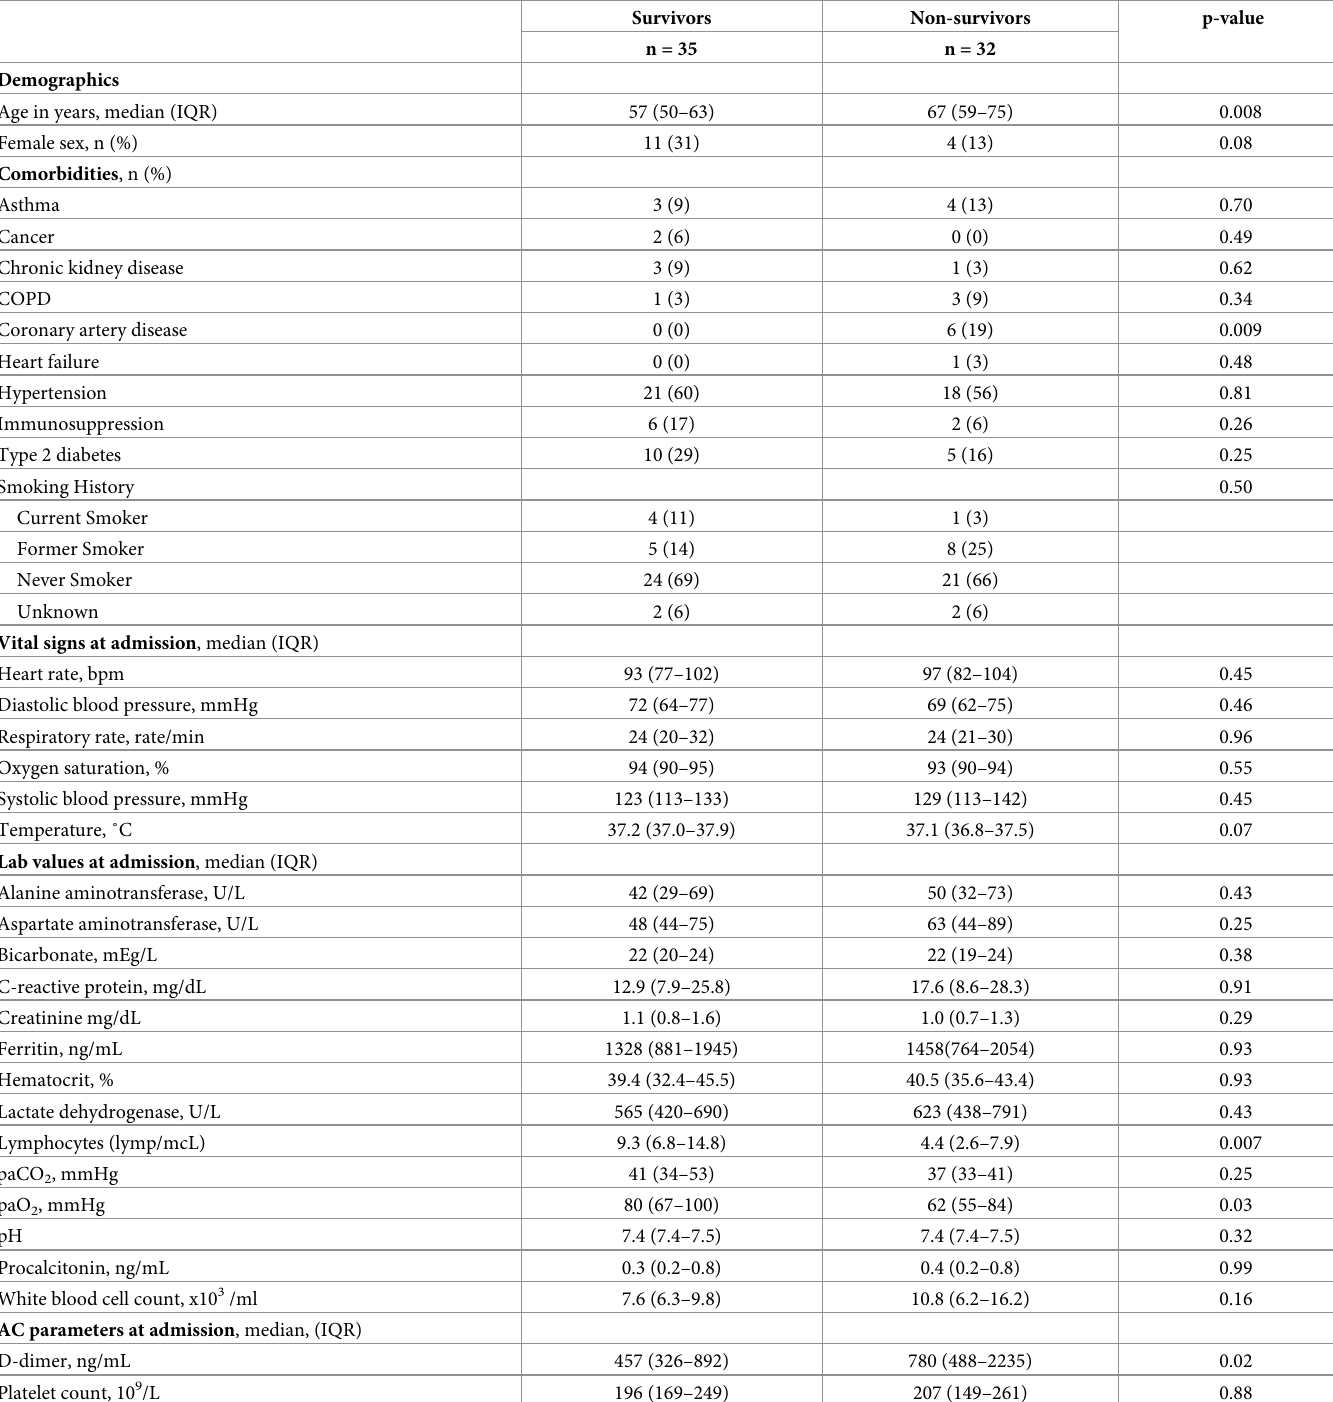
Table 4. Sample characteristics of survivors and non-survivors with 21 or more days ICU admission who received therapeutic dose